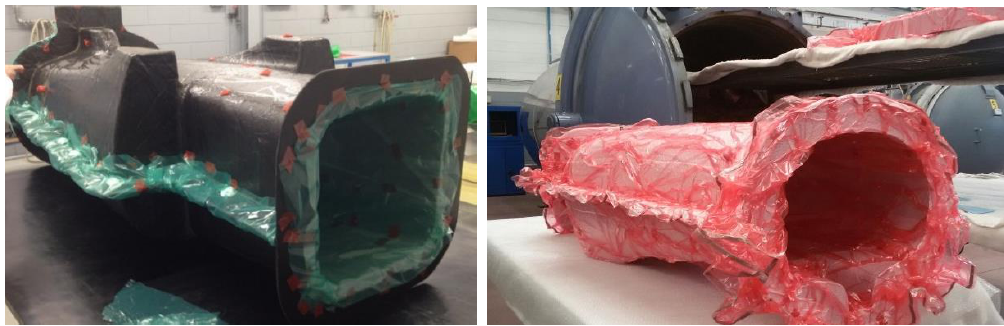
Figure 12. First lamination: Release film ( left ) and vacuum bag ( right ) on the female central mold .